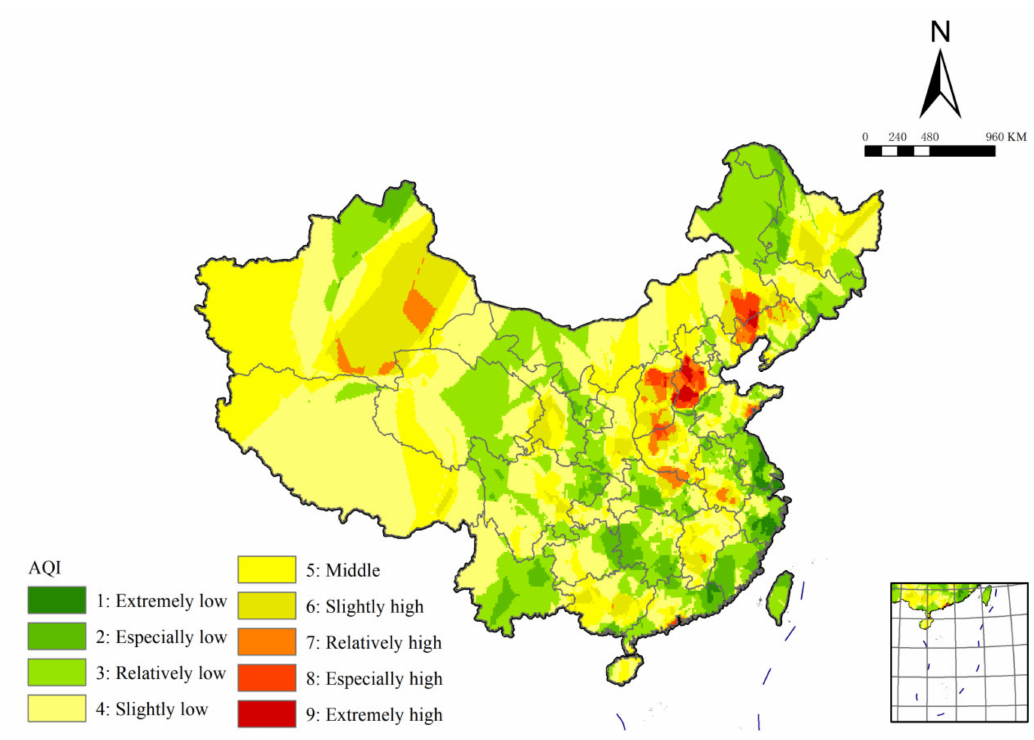
Figure 6. The spatial distribution of AQI.